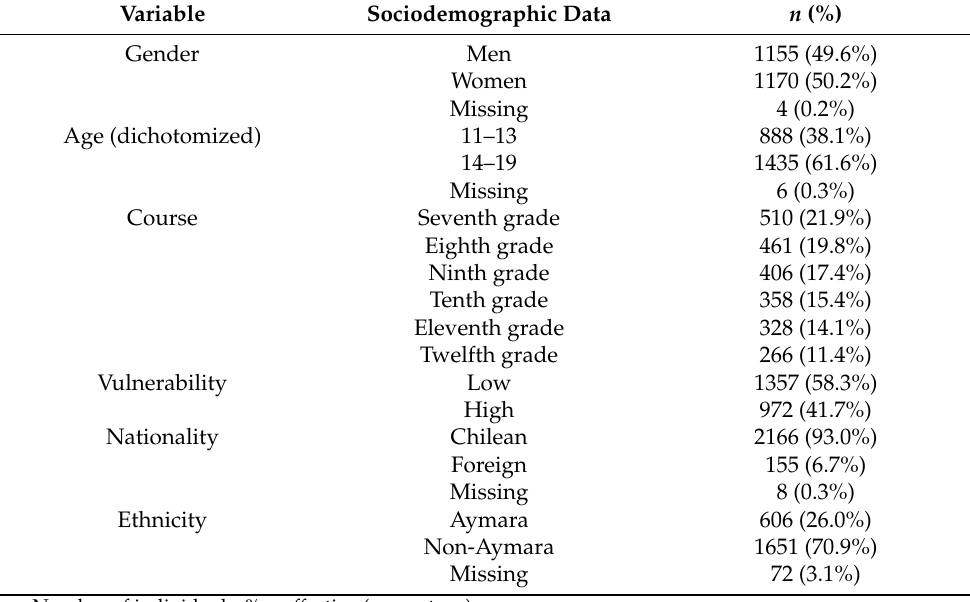
Table 1. Sociodemographic characteristics ( n = 2329).